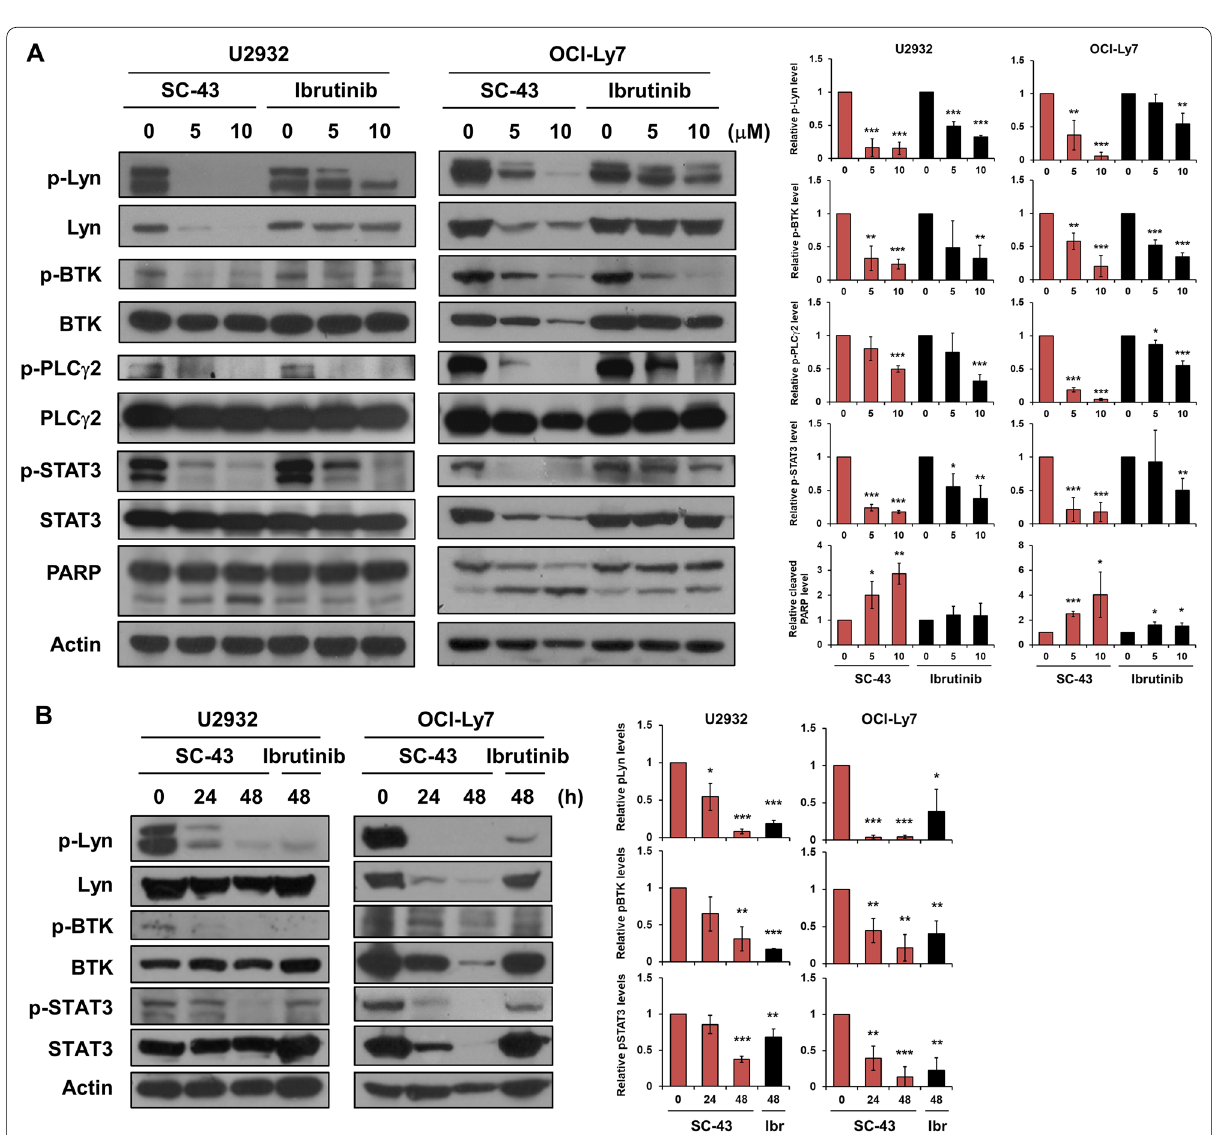
Fig. 4 SHP‑1 agonist inactivates Lyn signaling and elicits PAPR cleavage. A Whole‑cell extracts of U2932 and OCI‑Ly7 cells treated with SC‑43 or ibrutinib at indicated doses for 24 h were analyzed by Western blot analysis (left). The quantitative results of blotting were shown (right). B Whole‑cell extracts of U2932 and OCI‑Ly7 cells treated with SC‑43 or ibrutinib at 5 μM for indicated times were examined by Western blot analysis (left). The quantitative results of blotting were shown (right). Data are representative of three independent experiments. Student’s t ‑test, * P < 0.05; ** P < 0.01; *** P <